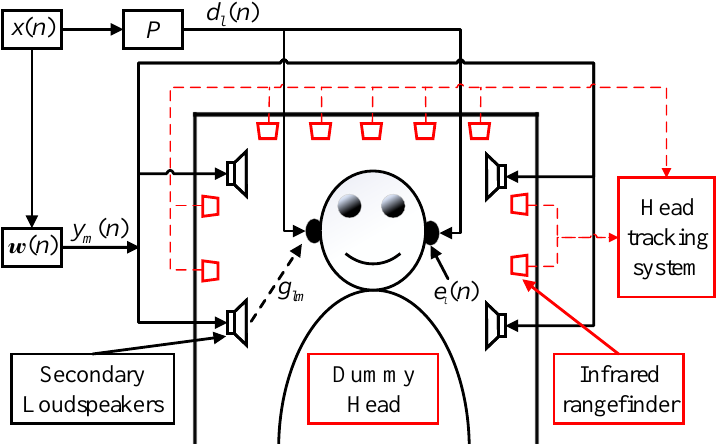
Figure 1. Schematic diagram of the active feedforward headrest integrated with